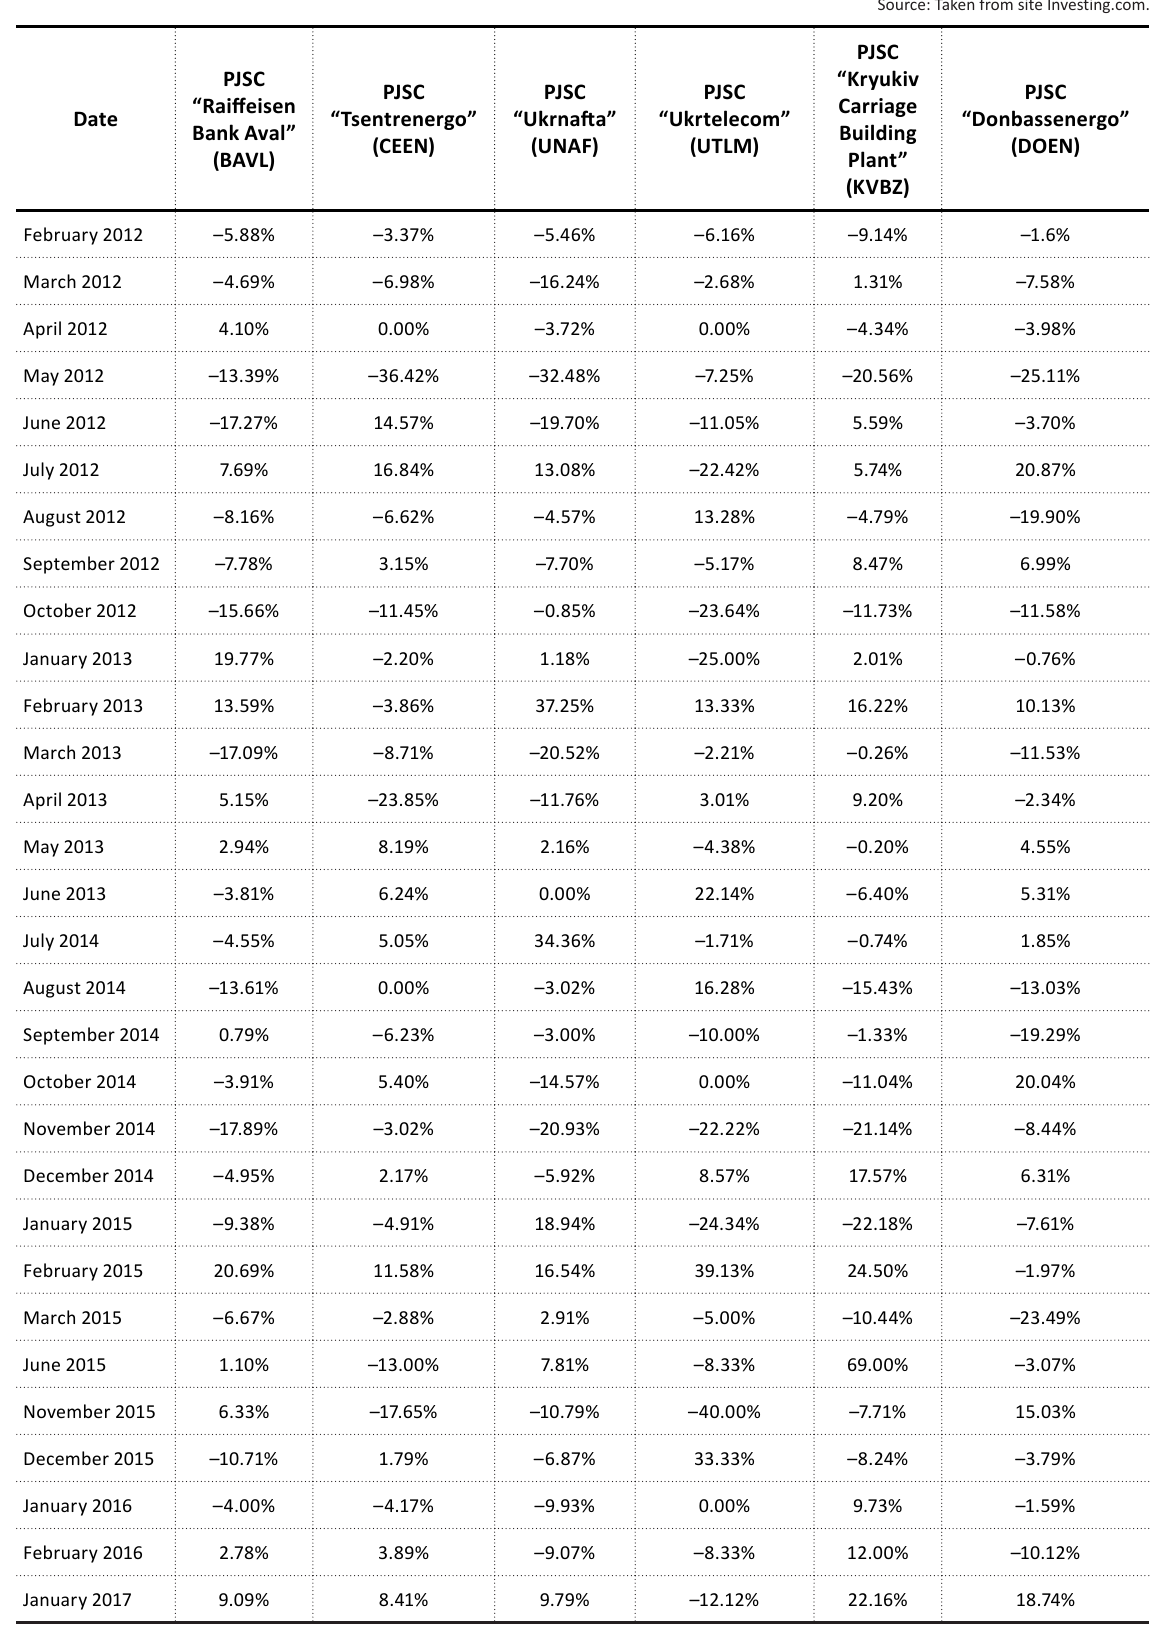
Table A2. The return of shares of ordinary companies per month from February 2012 to January 2017, %